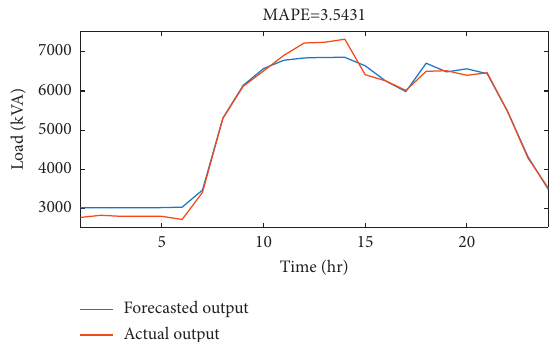
Figure 19: The Fuzzy-PSO prediction of Eidalfetir load.